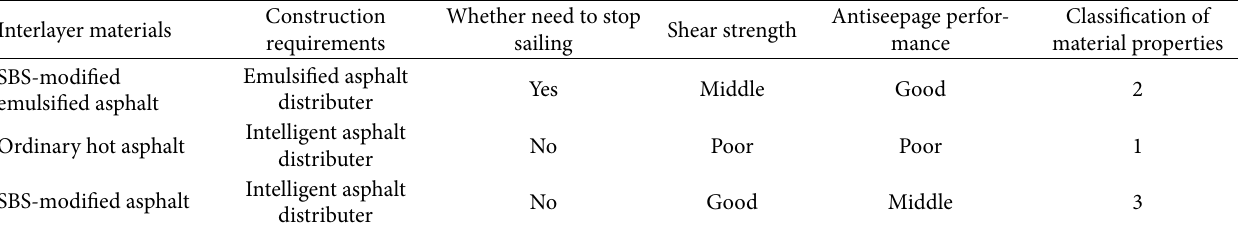
Table 14: Comprehensive properties of interlayer materials.